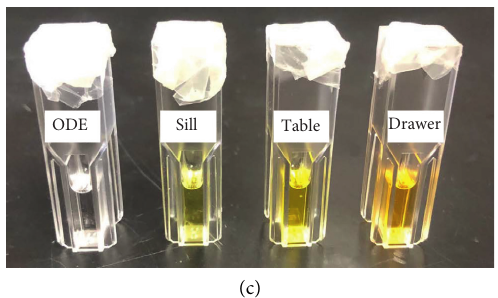
Figure 6: Plot of time-dependent photoluminescence (PL)/initial photoluminescence (PL � 0 days (b), and image at t � 9 0 ) (a), image at t days (c) for comparative samples of CdSe QD solutions (170 ° C; 2 min 30s). QDs were either left in a closed lab drawer with limited exposure to ambient light (solid line, square shape), placed on an open laboratory tabletop with continual exposure to mostly fluorescent light (dashed line, triangle shape), or placed on an interior windowsill with frequent exposure to sunlight and fluorescent light (dotted line, circle shape) for the course of the experiment. In the pictures from left to right, the samples are neat 1-octadecene, QDs left on the windowsill, QDs left on the tabletop, and QDs stored in the drawer,